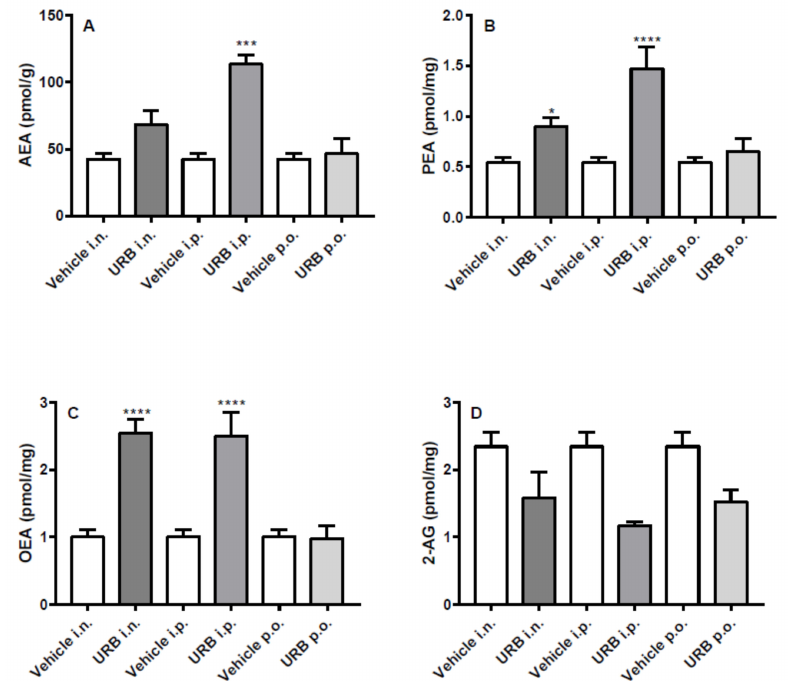
Figure 5. E ff ect of in vivo URB administration on cerebellum levels of NAEs and 2-AG. Levels of ( A ) AEA, ( B ) PEA, ( C ) OEA and ( D ) 2-AG following URB or vehicle (i.n., i.p. or p.o.) administration. Data are presented as mean ± SEM expressed as pmol per gram or milligram of wet tissue. * p < 0.01, *** p < 0.001 and **** p < 0.0001 post hoc comparisons with vehicle conditions, Tukey’s test.